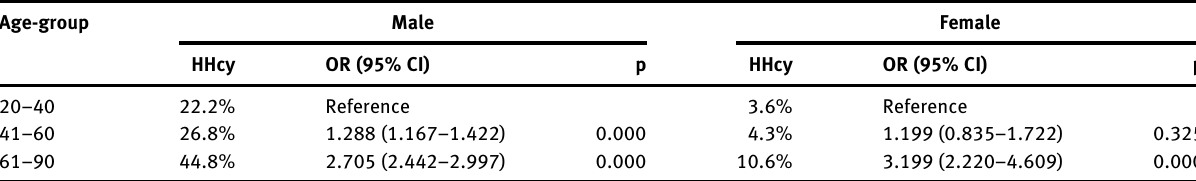
Table  : Logistic regression analyses of the risk of HHcy between ages in sex.